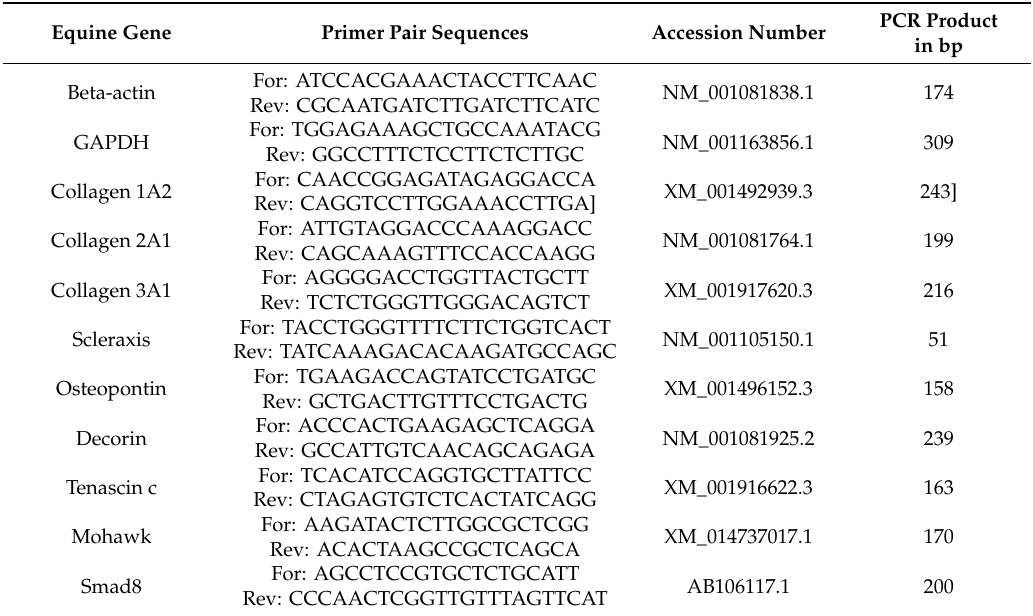
Table 2. Primer sequences for quantitative real-time